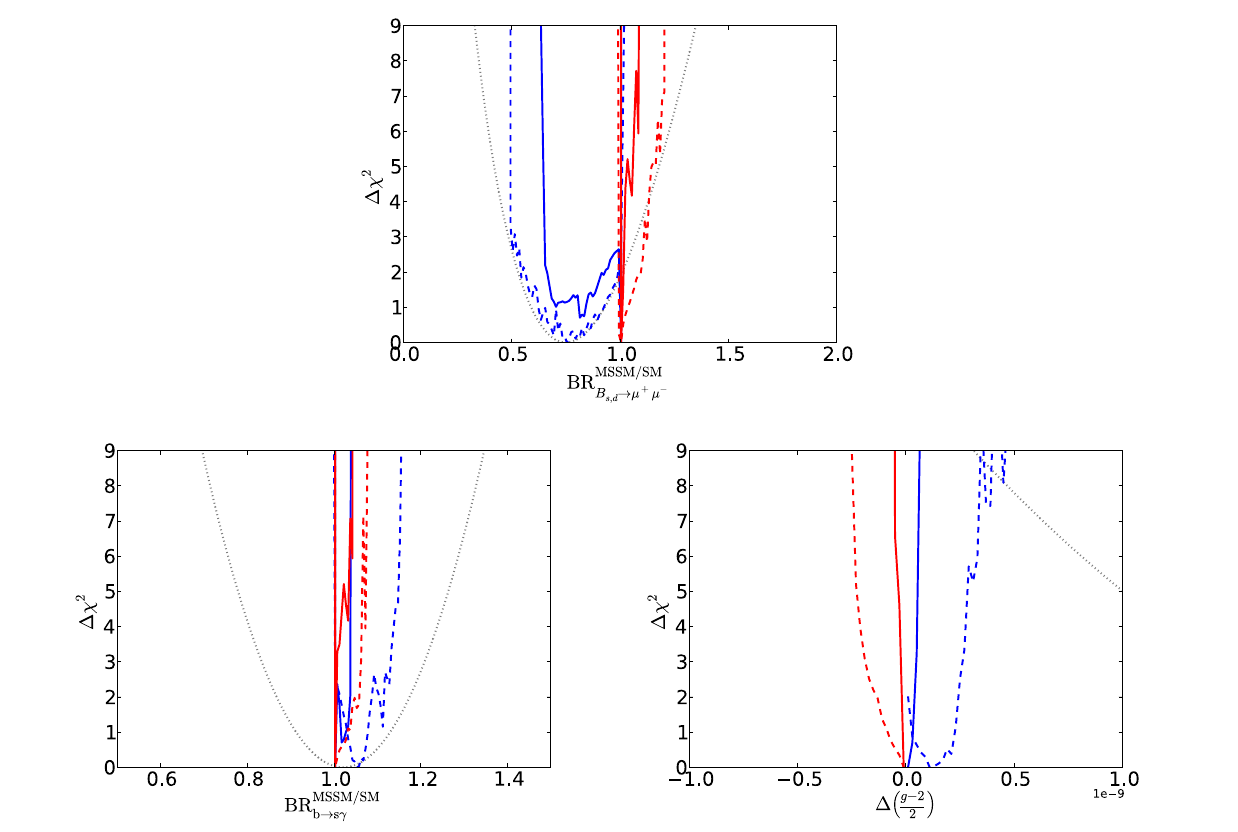
≤ (cid:4) and with (cid:4) ˜ χ 0 CDM ( dashed lines ), as well as both the 1 μ < 0 cases ( blue and red , respectively). The dotted lines represent the = (cid:4) current experimental measurements of these observables CDM ( solid lines ), 1